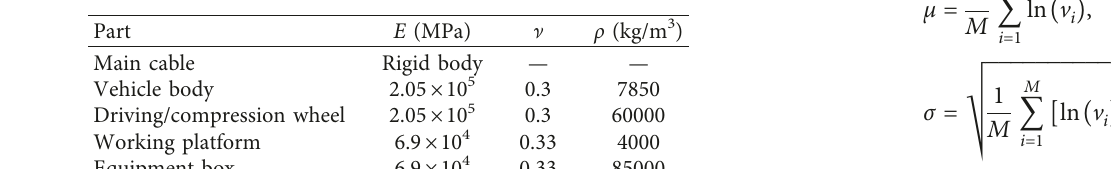
Figure 5: The main cable-inspection vehicle coupled FE model. Table 2: The parameters of the material used in the coupled FE model.